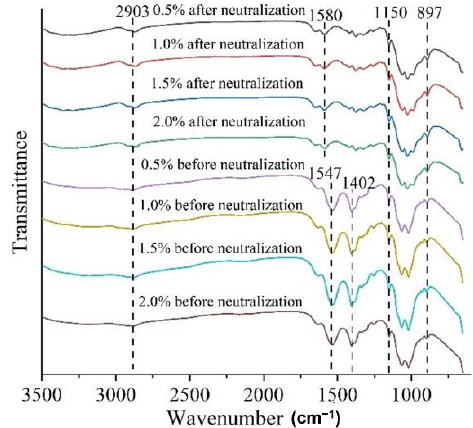
Figure 4. Effects of chitosan concentration on FTIR spectra of chitosan films before and after neutralization.